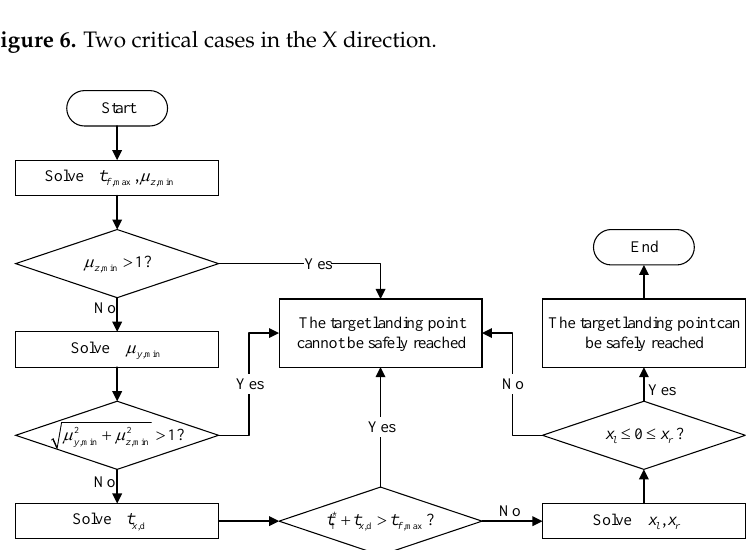
Figure 7. Flow chart of reachability